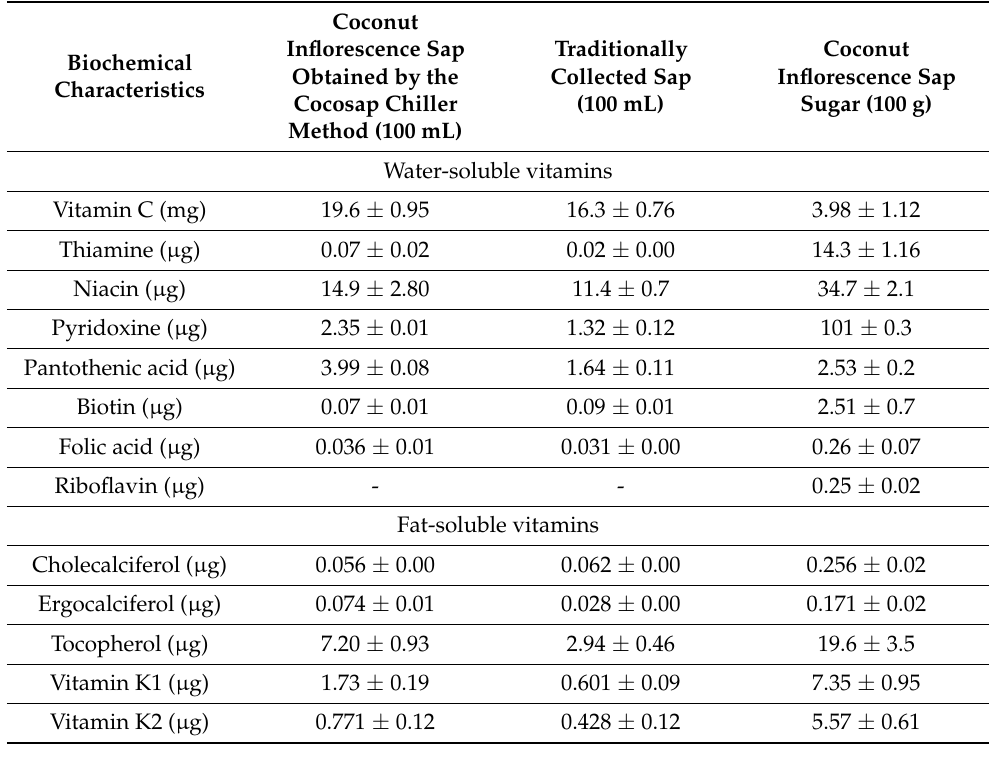
Table 7. Vitamin composition of coconut inflorescence sap obtained with a Cocosap chiller (conven- tional method) and coconut sugar [14].